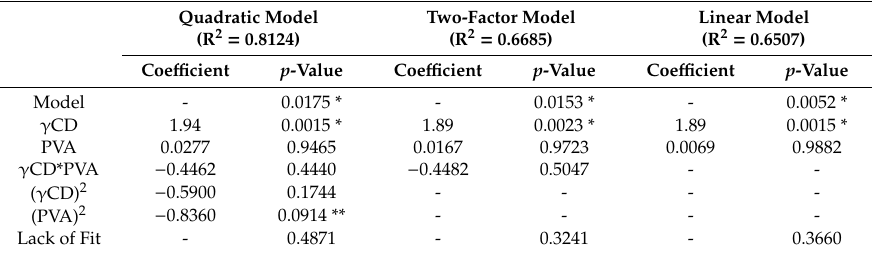
Table 4. Analysis of variance (ANOVA) of quadratic, two-factor, and linear models for the percentage of